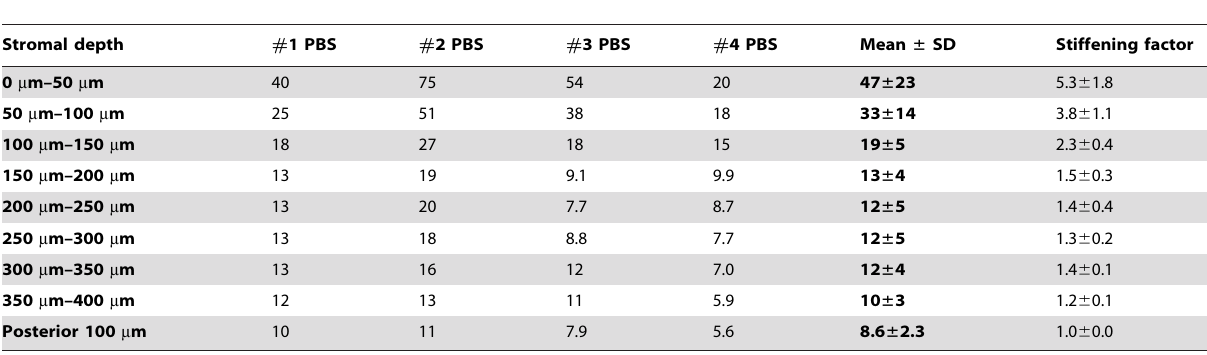
Table 2. Young’s modulus E (kPa) within stromal depth intervals in the PBS group.